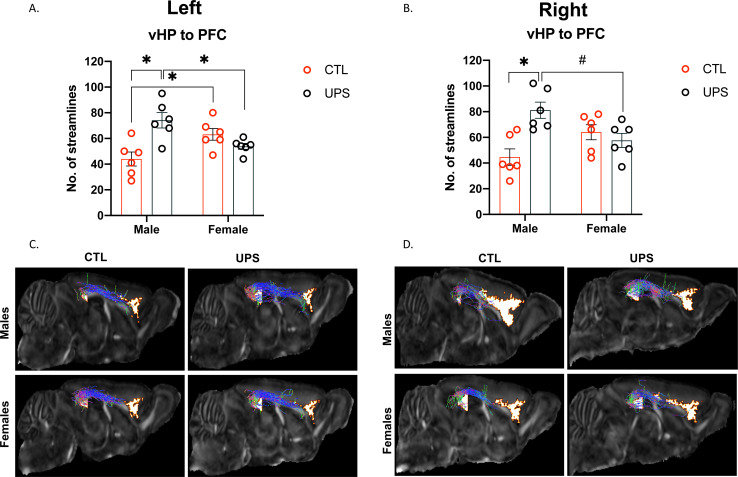
Ventral hippocampus–prefrontal cortex tractography for the left (A and C) and the right (B and D) hemispheres.Quantification of the number of streamline projections is summarized in A and B and representative tracing is shown in C and D. n = 6 per rearing condition and sex. Graphs represent mean and SEM, *p<0.05.